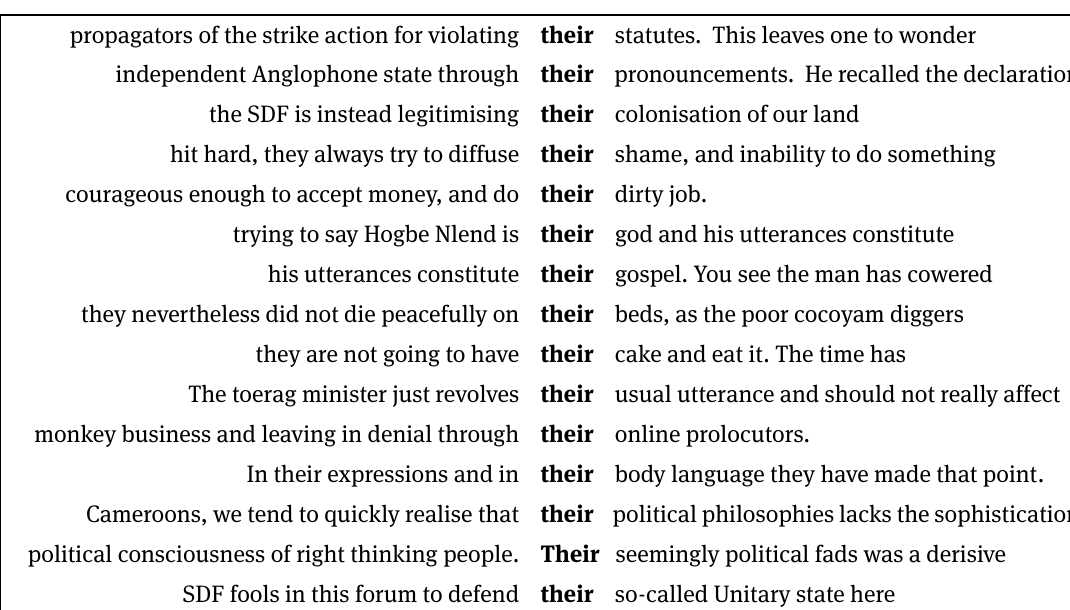
Figure 8 . Sample concordance list for